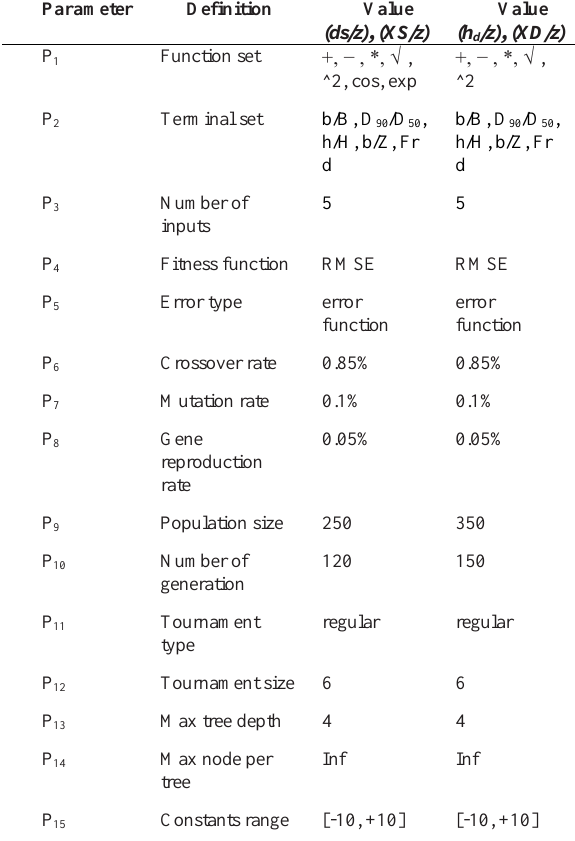
Table 3. Characteristics of employed GP for (ds/z), (XS/z), (h d /z) , and (XD/z) .